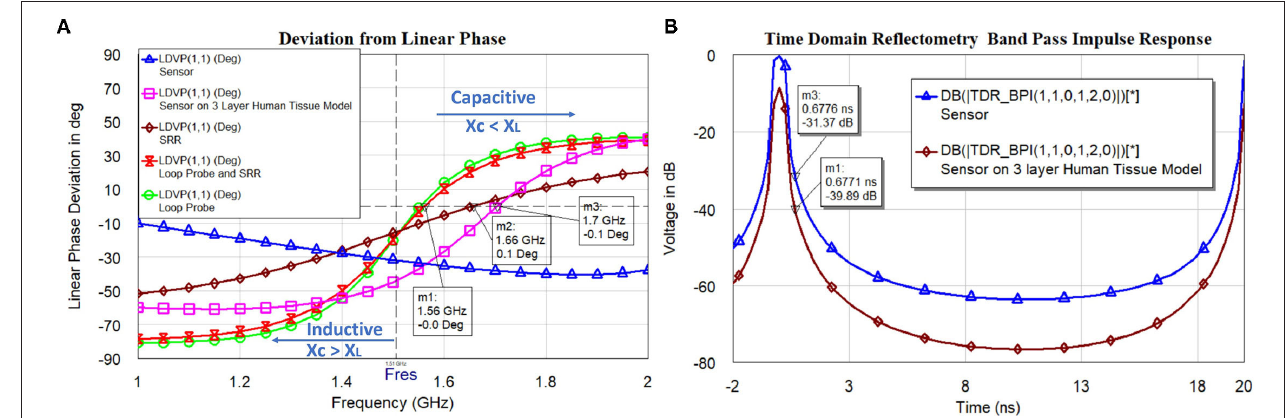
FIGURE 11 | (A) The linear phase (DLP) of the loop probe (a larger magnetic probe), SR, loop probe with SR, sensor, and sensor on a three-layer human tissue model, and (B) timedomain impulse response of the sensor and sensor on the three layers human tissue model.